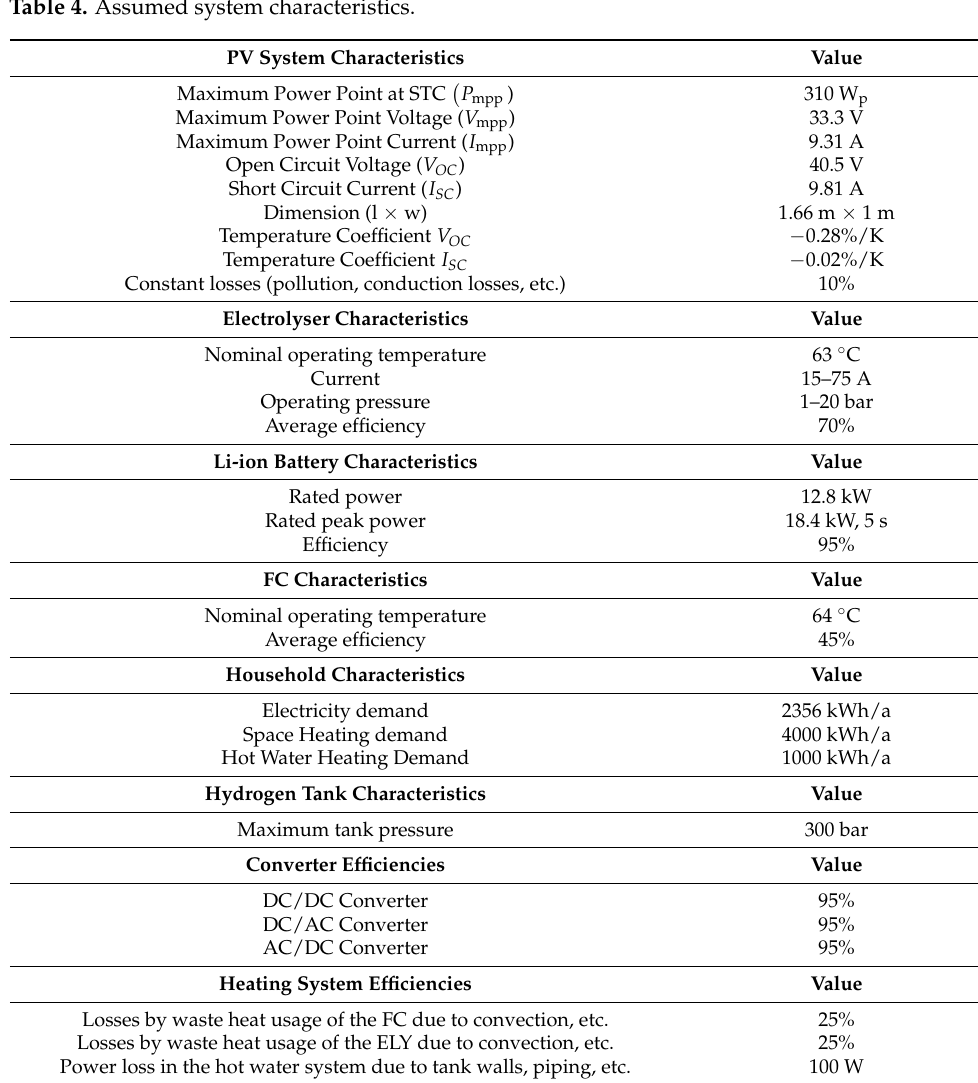
Figure 15. Energy production (left bar) and energy consumption (right bar) calculated by Simulink simulation for each month. Table 4. Assumed system